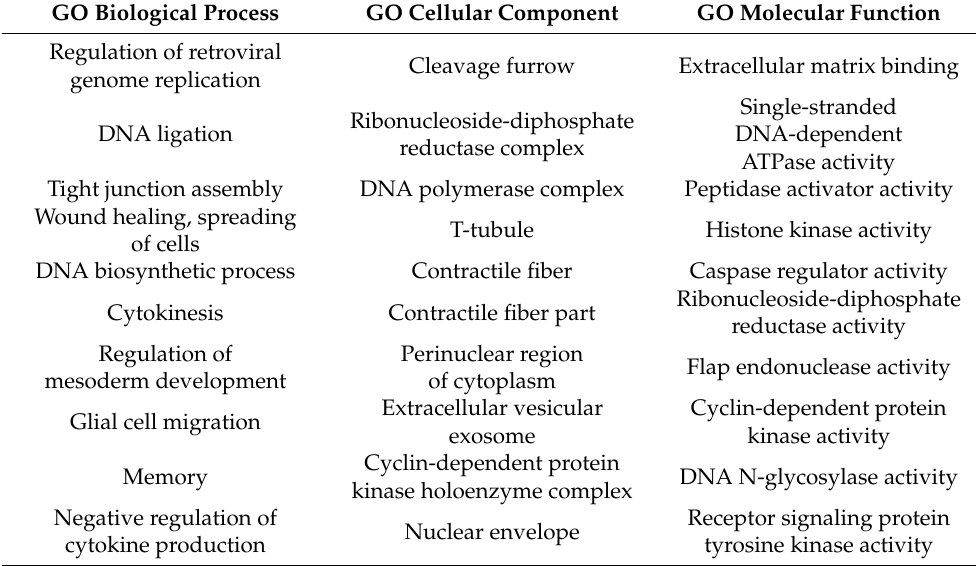
Table 6. Top 10 GO biological processes, cellular components, and molecular functions enriched from differentially expressed genes that are upregulated in MMC spinal cords compared to vehicle at E15. All GO pathways were >1.5-fold and p < 0.05.